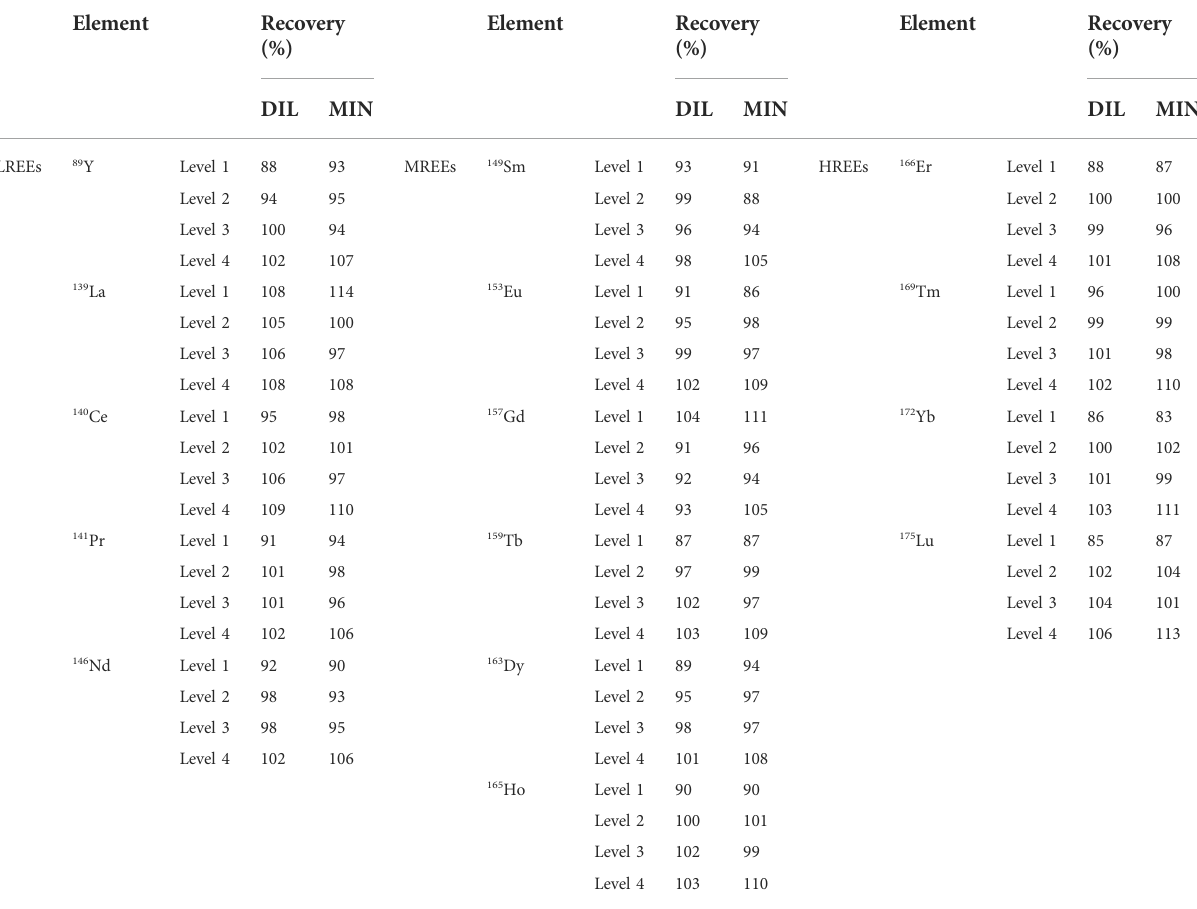
TABLE 6 Results of accuracy expressed as recovery (%) based on analysis of spiked samples at four different levels for the dilution (DIL) and digestion (MIN) sample preparation procedures. Spiked samples